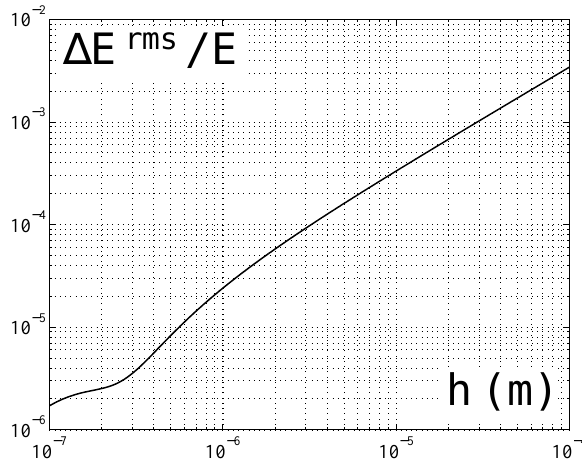
FIG. 4. Energy spread for a geometry approximating the LCLS undulator as a function of the depth of the corrugation ( a (cid:1) b (cid:1) 4 mm, L c (cid:1) 112 m, Nq (cid:1) 1 nC, E (cid:1) 14.3 GeV, and s (cid:1) 15 m